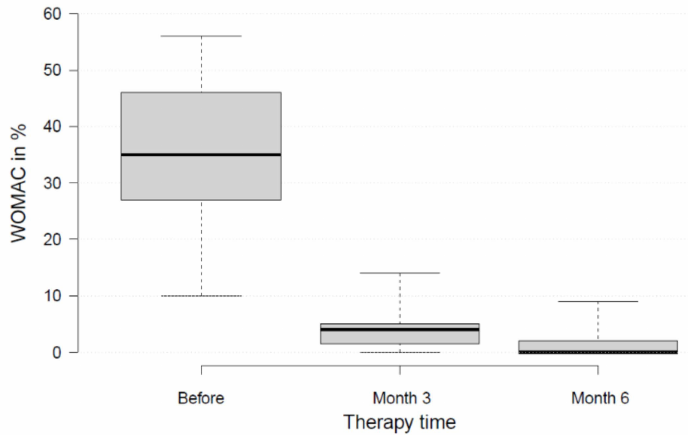
Figure 3. WOMAC score before therapy, and after three and six months of treatment.